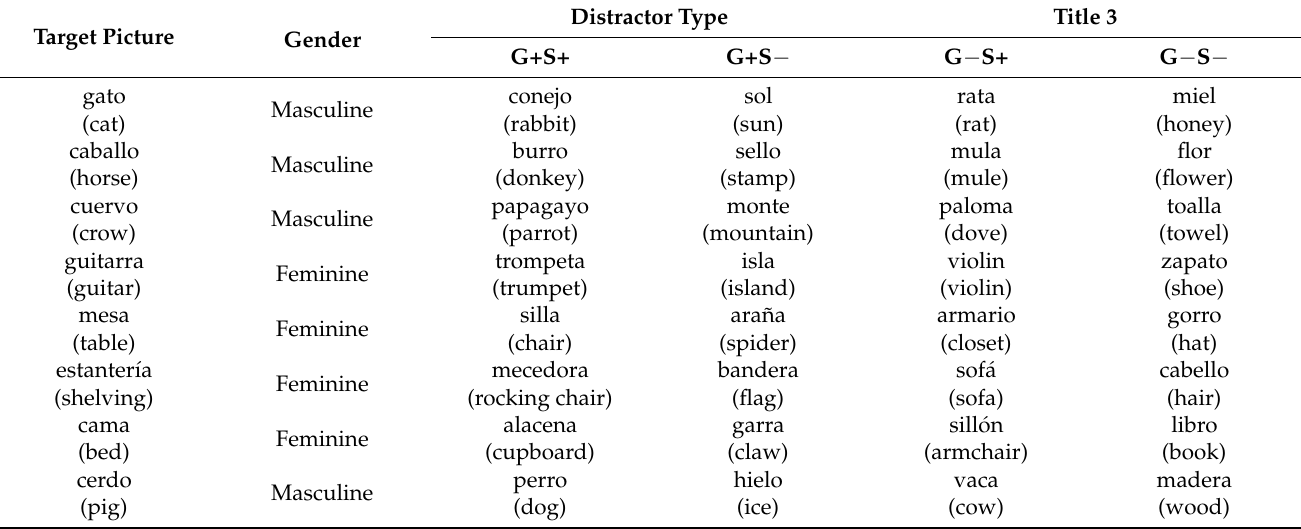
Table A1. Table of stimuli used in picture naming